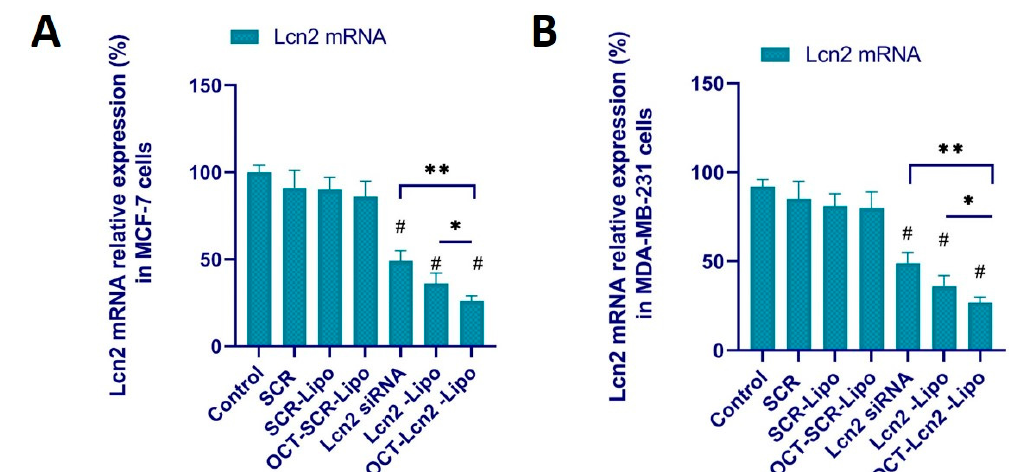
Figure 10. Lcn2 siRNA knockdown of Lcn2 gene expression at the mRNA level in MCF-7 and MDA-MB-231 cells using real time RT-PCR. ( A ) Lcn2 mRNA relative expression in MCF-7 cells after treatment with OCT-Lcn2-Lipo. ( B ) Lcn2 mRNA relative expression in MDA-MB-231 cells after treatment with OCT-Lcn2-Lipo. The data were expressed as mean ± SD ( n = 3). (# p ≤ 0.05 as compared to control group, * p ≤ 0.05, ** p ≤ 0.01 and as compared to Lcn2 siRNA group).